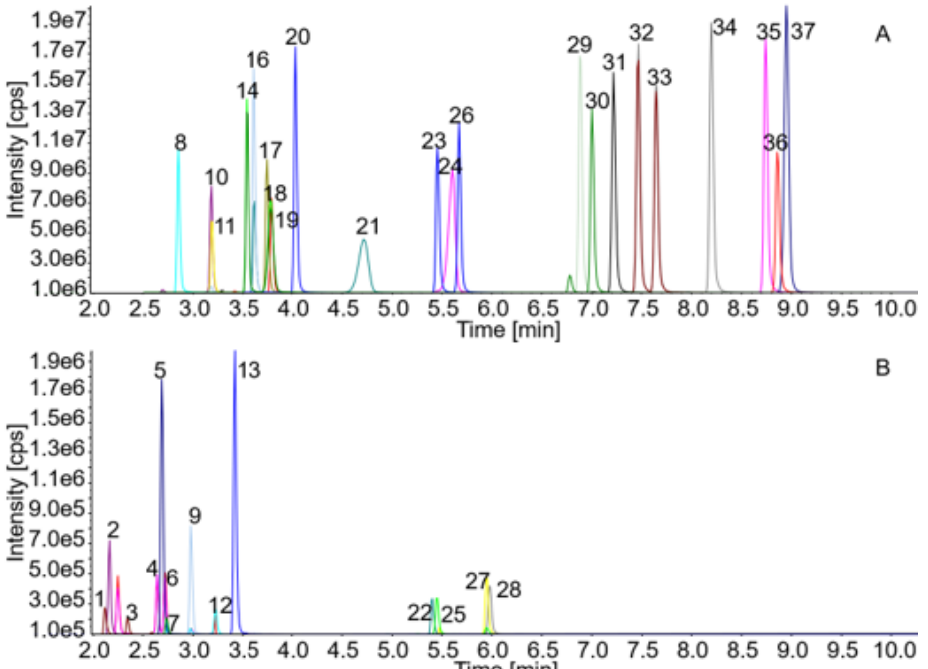
Figure 1. Chromatograms of 36 dipeptides and the internal standard norleucine.0.5 pmol per analyte were loaded on column. ( A ) Dipeptides with higher signal intensity; ( B ) those with lower intensity yields. Compounds are corresponding to the numbers in the chromatograms as follows: 1. Ser-His; 2. Gly-His; 3. His-Ser; 4. Carnosine; 5. Ser-Gln; 6. Ala-His; 7. Anserine; 8. Gly-Asp; 9. Asp-Gln; 10. Glu-Ser; 11. Gly-Glu; 12. His-Ala; 13. Ala-Gln; 14. Ala-Gly; 15. Ser-Ala; 16.